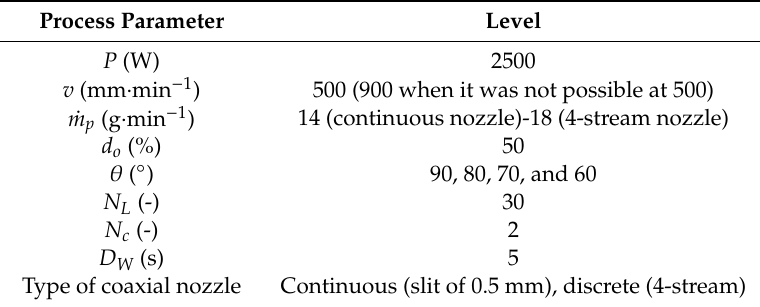
Figure 5. ( a ) Scheme of the approach used for calculating the total width; ( b ) increase of the total width with the number of layers. Table 4. Process parameters for manufacturing inclined walls.